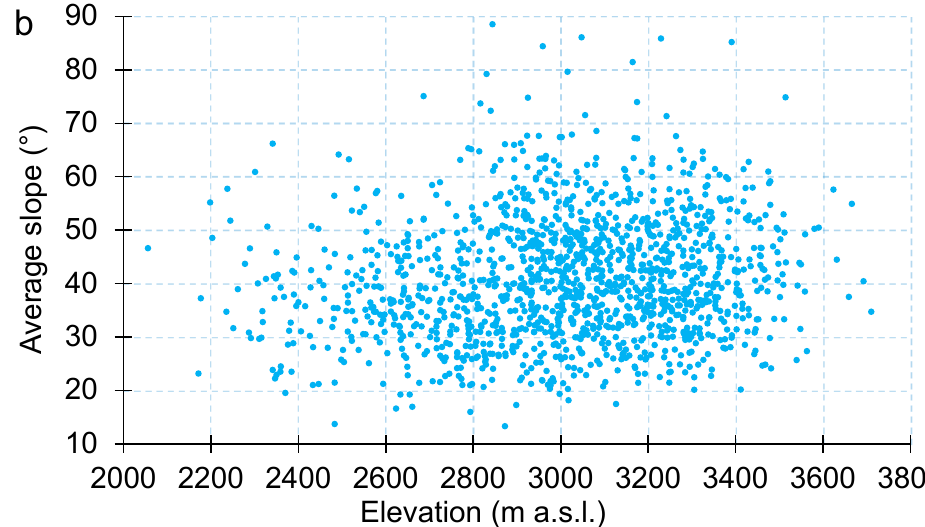
Figure 8. ( a )—Mean average slope of all rock glaciers inventoried across the Greater Caucasus according to the different sections (western, central, and eastern) and slopes (northern and southern). Error bars are based on standard deviation (1 σ ). ( b )—Spatial distribution of mean elevation versus average slope for all rock glaciers larger than 0.01 km 2 in the Greater Caucasus.